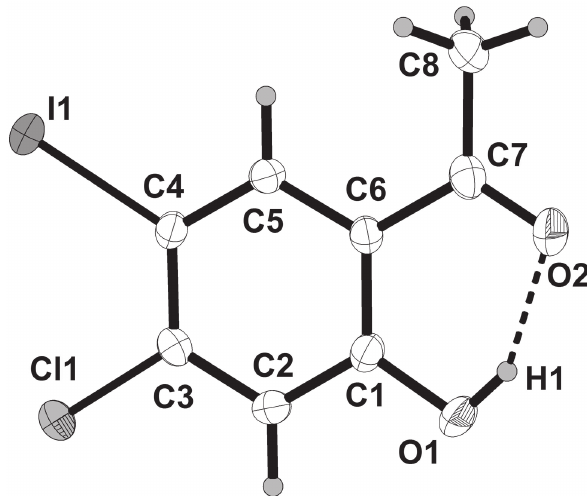
Table 1: Data collection and handling.